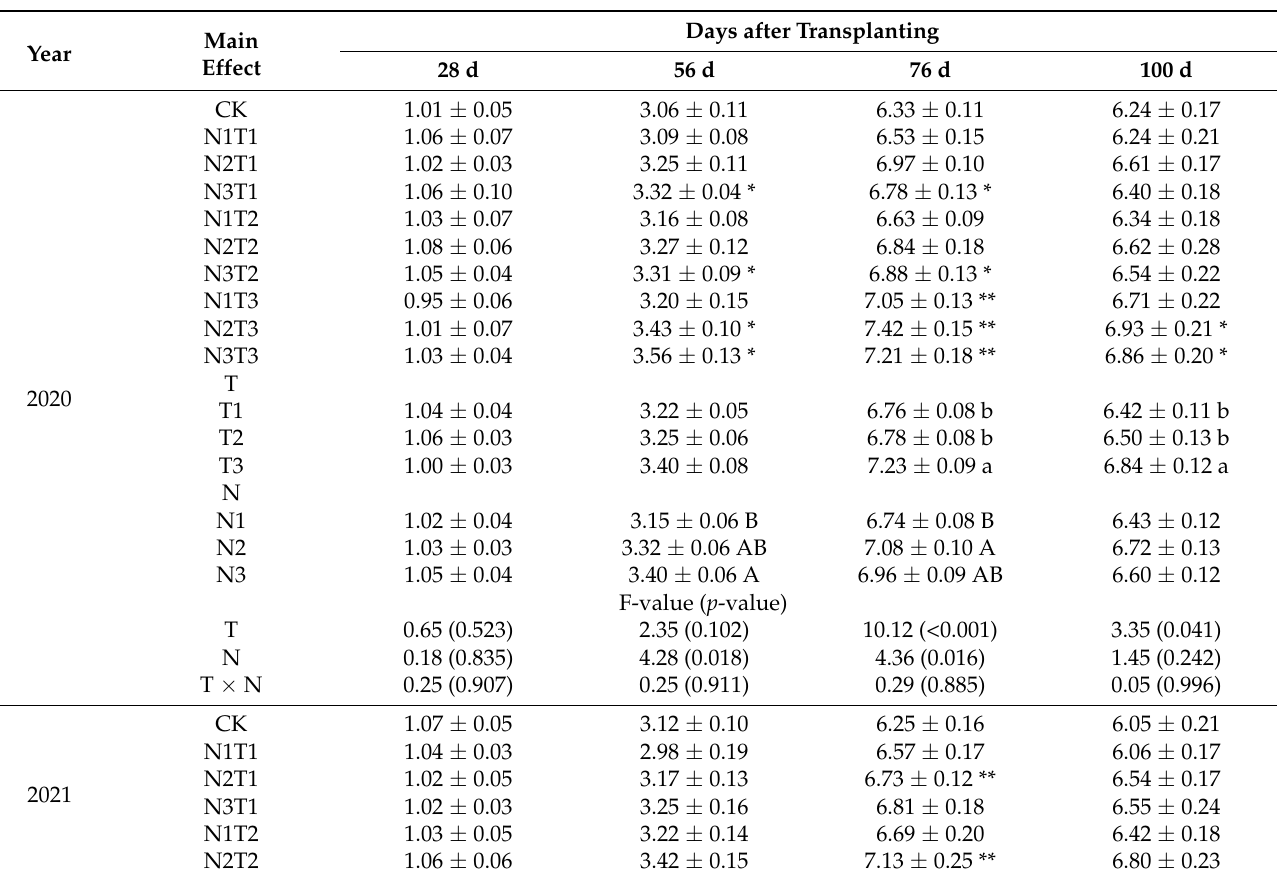
Table 6. Response of tomato leaf area index (LAI, m 2 · m − 2 ) to different urea types and N application rates in the